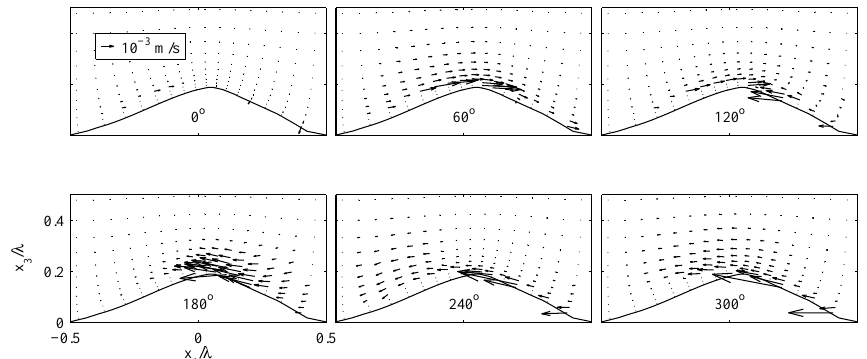
Figure 8. Observed suspended sand fluxes at six different phases of the oscillation.